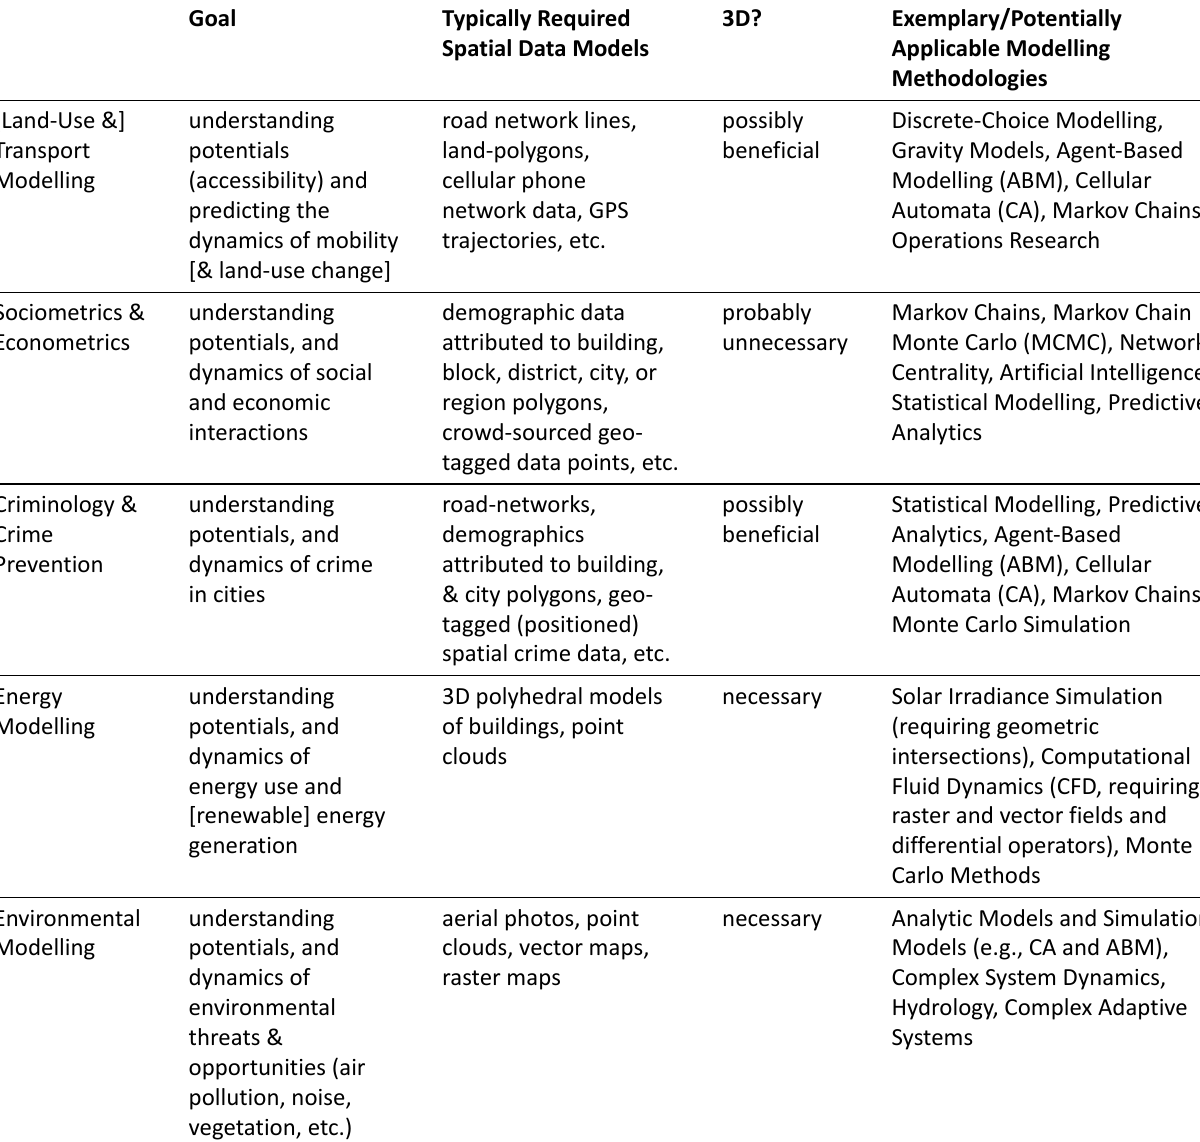
Table 1. A list of typical goals, required spatial data types, and analytic (mathematical) or simulation (computational) mod- elling approaches of urban